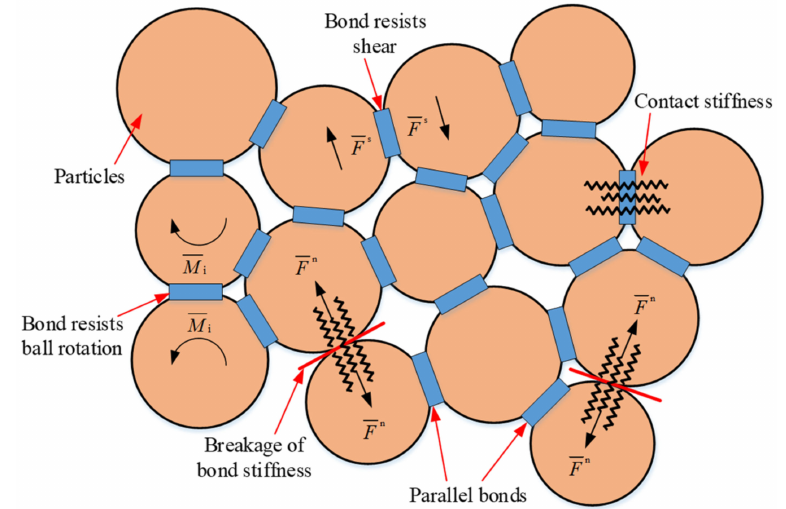
Figure 1. Cohesion model and its micromechanical behavior in the PBM